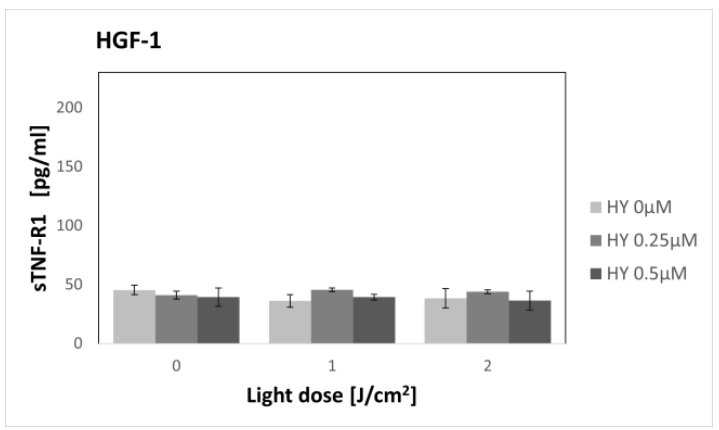
Figure 10. The concentration of sTNF-R1 in the supernatants from gingival fibroblast HGF-1 line. The values represent the means ± SE.